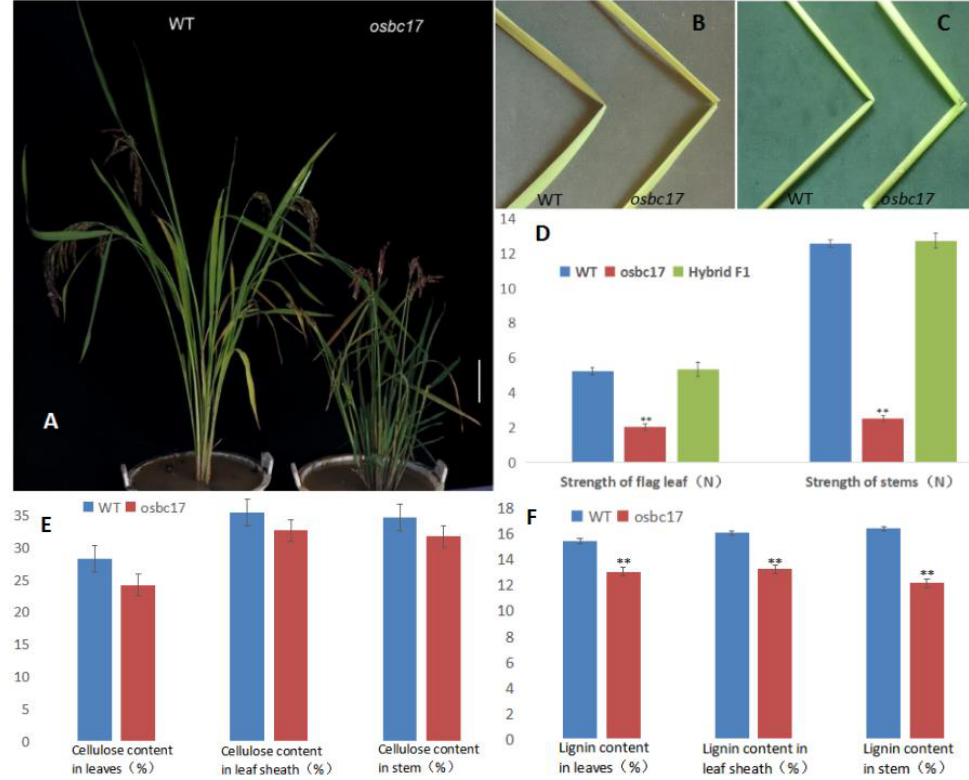
Figure 1. Phenotypes of wild-type Pingtangheinuo and brittle stem mutant osbc17 . ( A ) Rice plants of wild-type and brittle stem mutant. Bar = 20 cm. ( B , C ) Fracturing of wild-type Pingtangheinuo and brittle stem mutant osbc17 in response to external force. Fracture points of flag leaves ( B ) and stem internodes ( C ) of wild-type and mutant plants. ( D ) Comparison of the mechanical strength of the WT, the osbc17 mutant, and their F 1 progeny. **, significantly different at p < 0.01. ( E , F ) Cellulose contents ( E ) and lignin contents ( F ) of wild-type Pingtangheinuo and brittle stem mutant osbc17 plants . Asterisks indicate significant differences (**, p < 0.01).